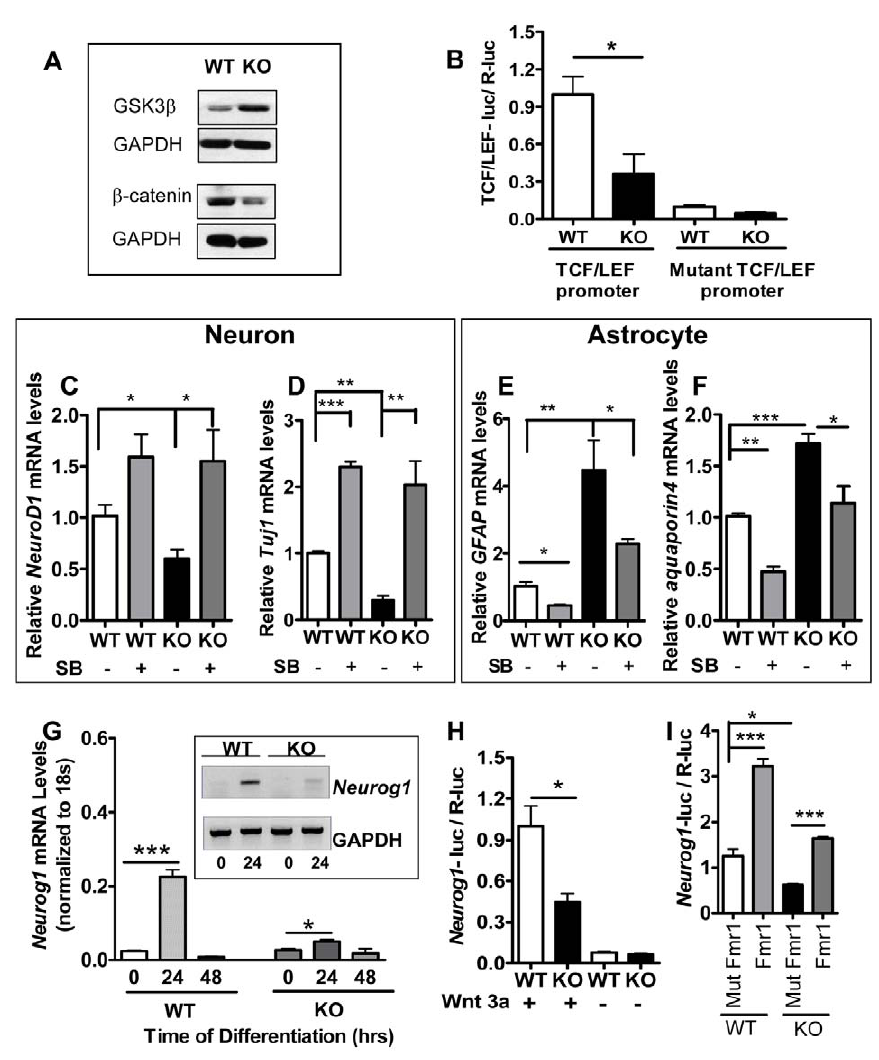
Figure 6. Loss of Fmrp leads to a deficit in the Wnt signaling pathway and reduced Neurog1 expression in aNPCs. (A) In differentiating Fmr1 KO aNPCs (24 hours after initiation of differentiation), the GSK3 b protein level was higher and b -catenin protein level was lower compared with differentiating WT aNPCs. (B) Differentiating Fmr1 KO aNPCs have defective Wnt signaling, as indicated by the level of TCF/LEF-luciferase activity. A mutant promoter with the TCF/LEF site mutated was used as a negative control (n=3). (C–F) The GSK3 b inhibitor SB216763 (SB) could partially rescue the reduced neuronal (C,D) and increased astrocyte (E,F) differentiation deficits of Fmr1 KO aNPCs. SB (dissolved in DMSO) was added at initiation of differentiation at 4 m M. An equal amount of DMSO was added to WT and KO control aNPCs. Cell differentiation was assessed by the relative mRNA levels of NeuroD1 (C), Tuj1 (D), GFAP (E), and aquporin4 (F). GAPDH mRNA levels were used as an internal control. (G) Real-time quantitative PCR results show that early differentiating (24 hours) WT aNPCs transiently express high levels of Neurog1 ( , 10-fold induction compared with 0 hour; n=4). This Neurog1 induction is drastically impaired in differentiating (24 hours) Fmr1 KO aNPCs ( , 2 6 -fold; n=4). Proliferating aNPCs (0 hour), and later differentiating (48 hours) cells, expressed a minimal level of Neurog1 . Inset, similar results obtained by regular RT-PCR. (H) The Wnt receptor ligand, Wnt3a, is required for activating the Neurog1 promoter during differentiation. In the presence of Wnt3a, Neurog1 promoter activity was significantly lower in Fmr1 KO aNPCs compared with WT cells. Neurog1 promoter activity was undetectable in the absence of Wnt3a (n=3). (I) Exogenously expressed wild-type Fmr1, but not mutant Fmr1, could promote the Neurog1 transcription as assessed by Neurog1 promoter activities in both Fmr1 KO and WT aNPCs (n=3). All data are shown as mean 6 SEM, and Student’s t-test was used for all the analyses. *, p , 0.05, **, p , 0.01***, p ,